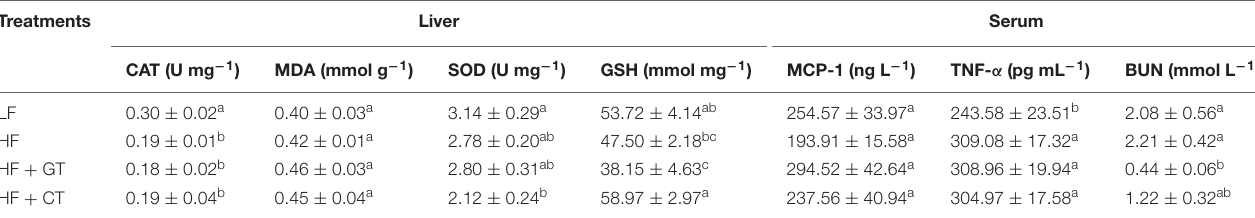
TABLE 1 | Biochemical levels of C57BL/6J mice. Treatments